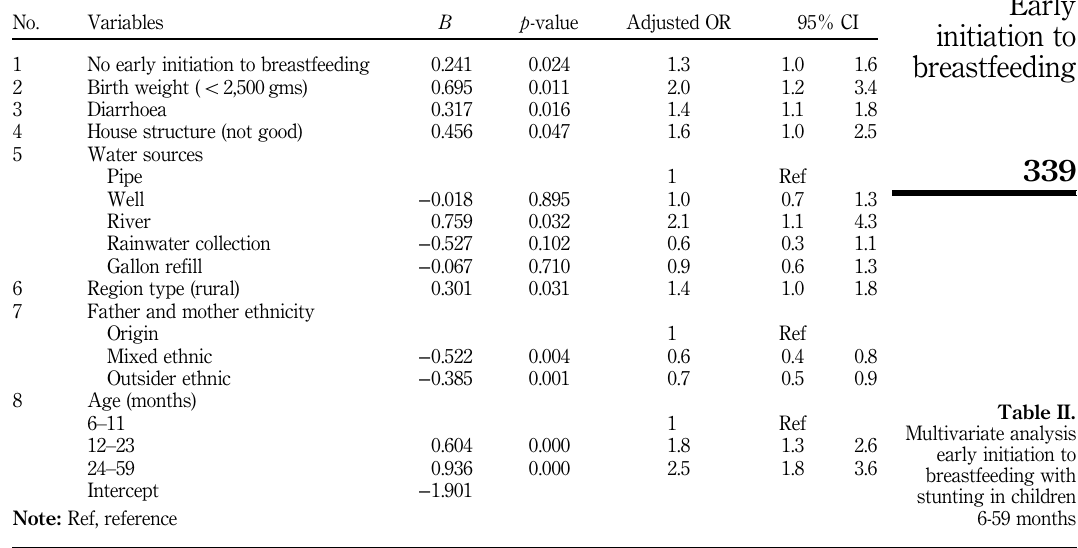
Table II. Multivariate